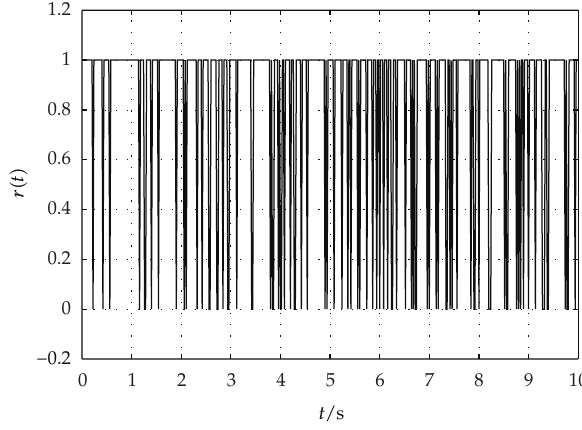
Figure 1: Stochastic variable r (cid:5) t (cid:6)